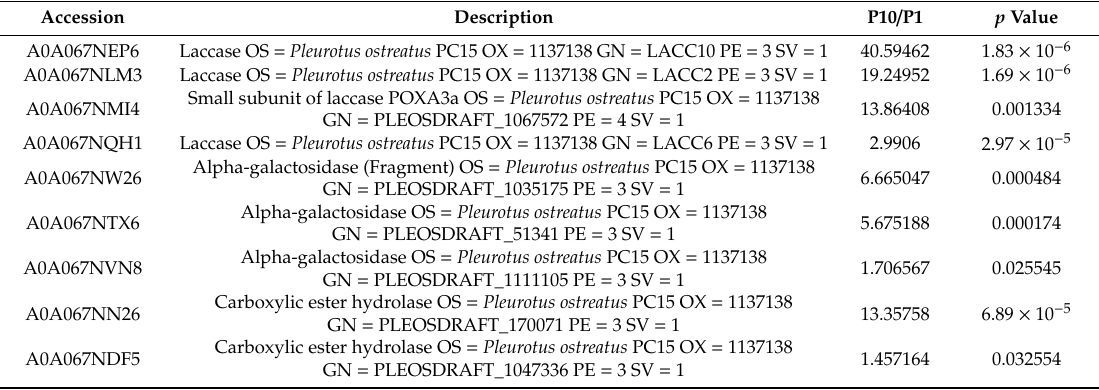
Alpha-galactosidase OS = Pleurotus ostreatus PC15 OX = 1137138 GN = PLEOSDRAFT_51341 PE = 3 SV =